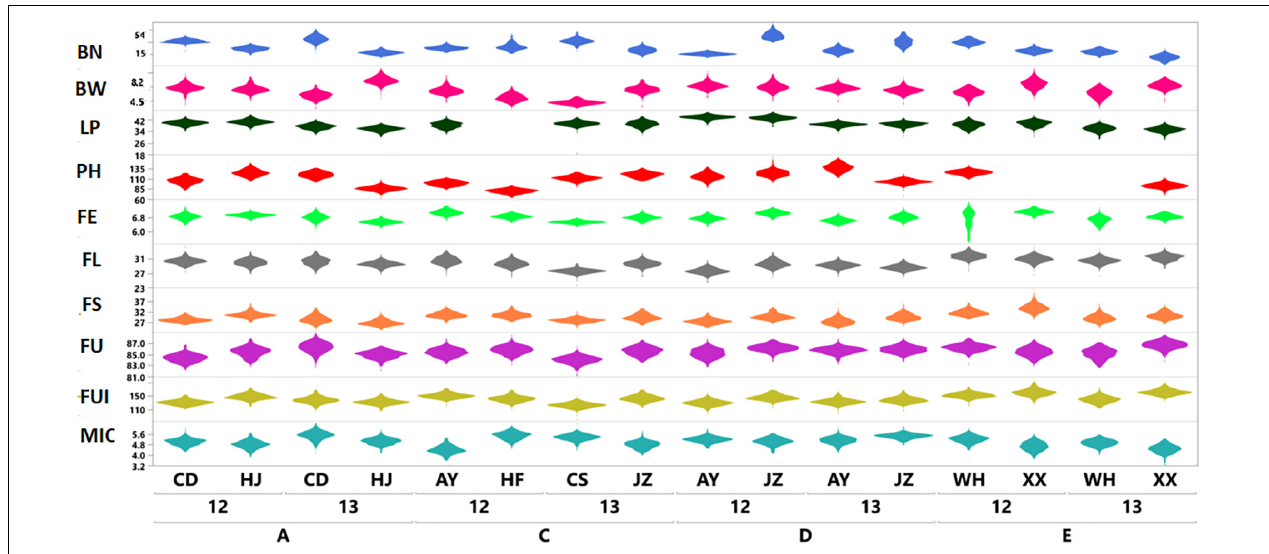
FIGURE 1 | Violin plots based on phenotypic variation of ten agronomic and fiber quality traits of F 1 hybrids ( Y axis) from four sets (SetA, SetC, SetD, and SetE) across multiple environments for two years; 2012 and 2013 ( X axis). Legends on top right in different colors are representing ten evaluated phenotypic traits.